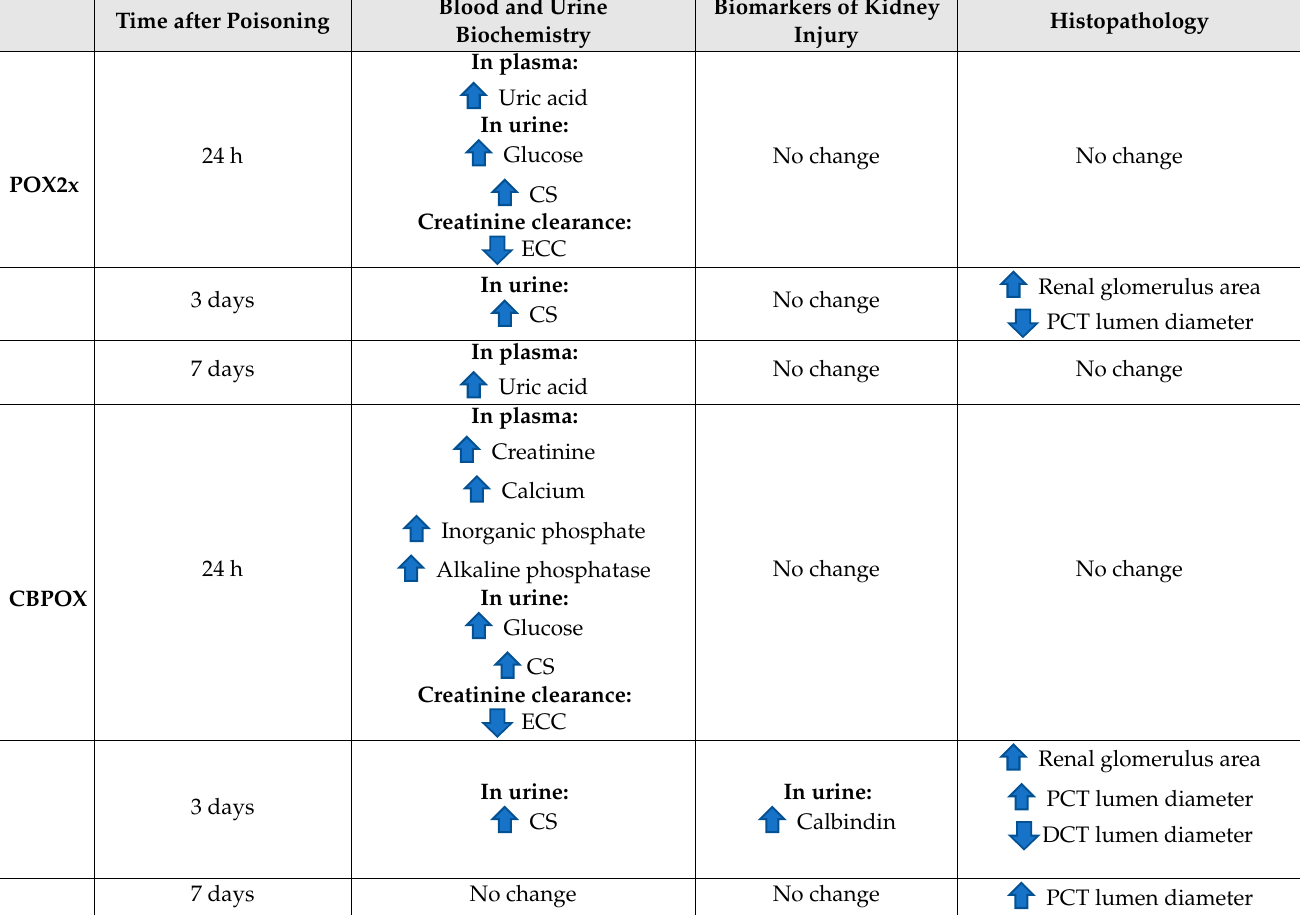
Table 2. Signs of POX nephrotoxicity in the M1 and M2 model .